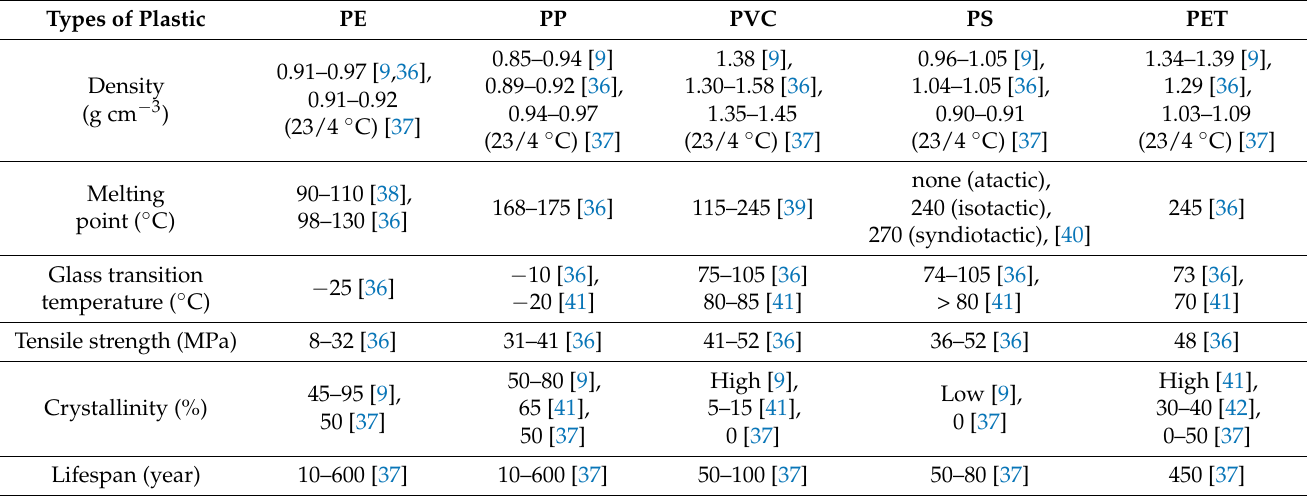
Figure 1. Chemical structures of: ( A ) polyethylene, ( B ) polypropylene, ( C ) polyvinyl-chloride, ( D ) polystyrene, and ( E ) polyethylene terephthalate. Table 1. Physical and chemical properties of most used plastics.